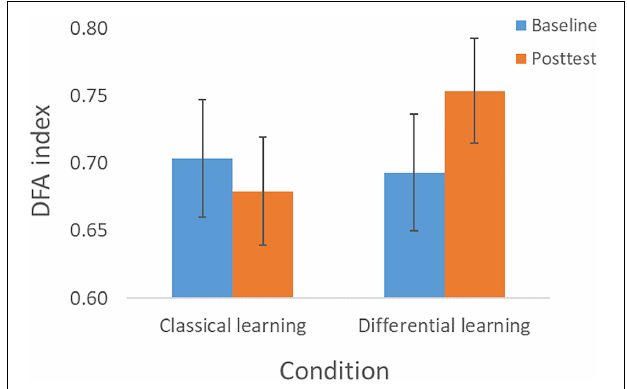
FIGURE 3 | Complexity—as expressed in the DFA index—according to Session (Baseline and Posttest) and Training condition (Classical learning and Differential learning). The error bars correspond to the 95% confidence